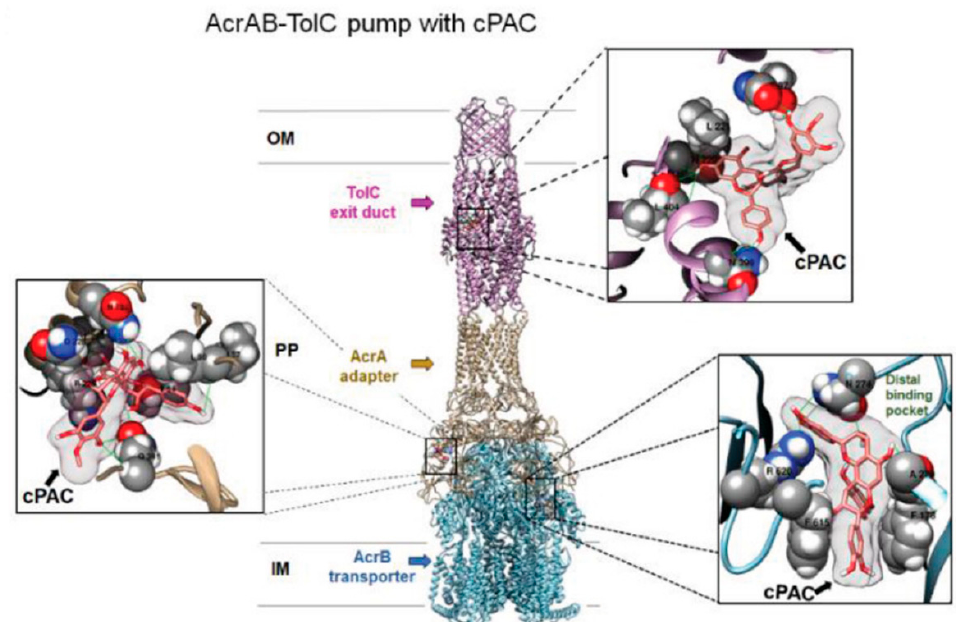
Figure 3. Molecular docking analysis of cPAC in the AcrAB–TolC efflux pump. (A) Complete side view with ribbon representation of docked complexes of efflux pump proteins with A-type cPAC molecule. The inset views show the electron density map (2F0–Fc) of cPAC in binding sites of multidrug efflux pump exit duct (TolC in pink), adapter (AcrA in gold), and transporter (AcrB in blue) proteins. OM, outer membrane; PP, periplasmic space; IM, inner membrane. Adapted from [40], Adv. Sci . 2019.